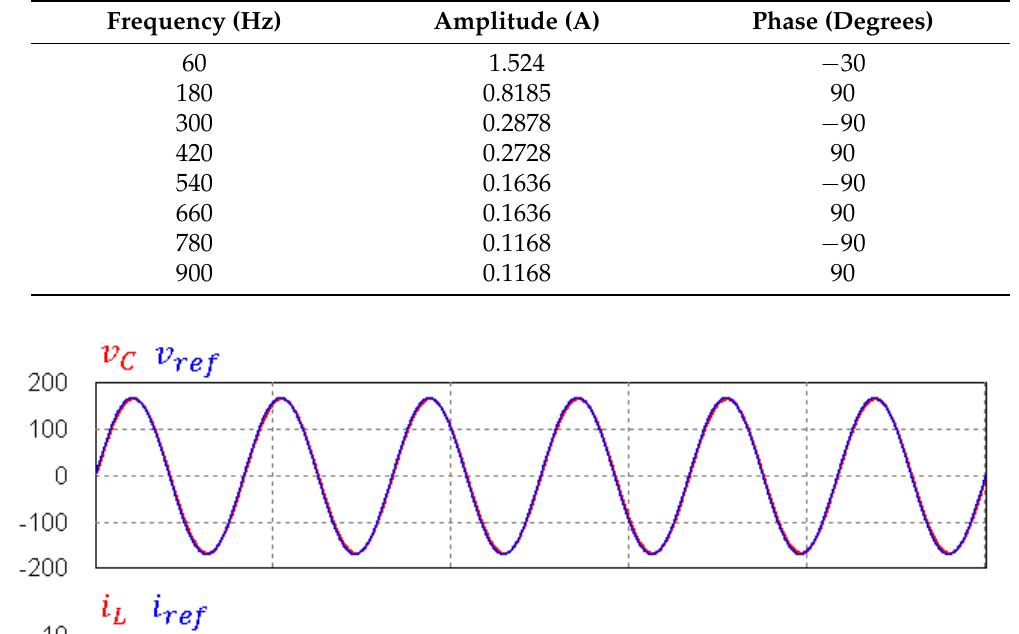
Table 3. Parameters of the CFL-type nonlinear load.